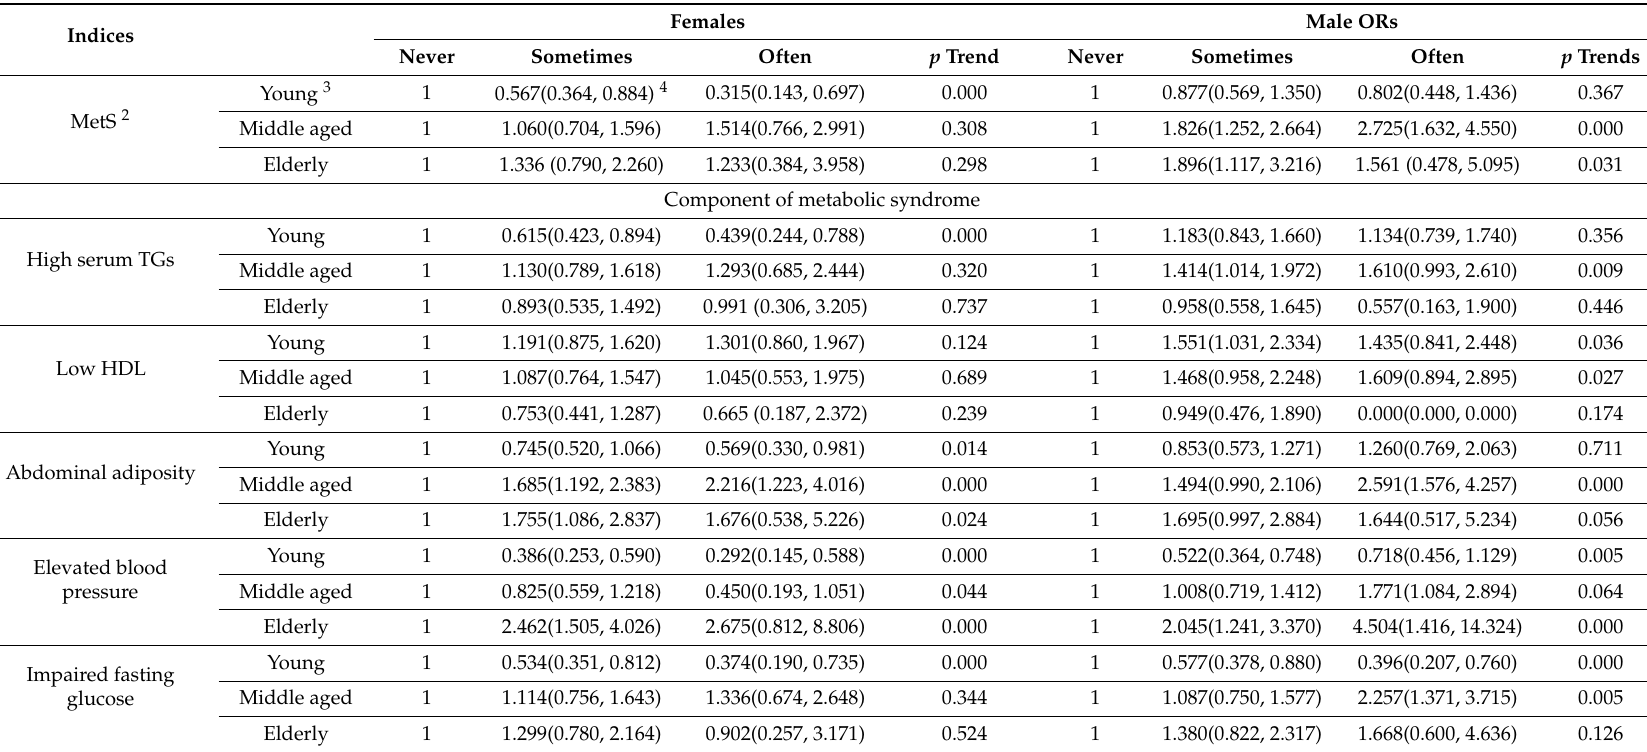
Table 4. Multivariable 1 adjusted analysis of the association between EAFH and MetS 2 and its components for each age